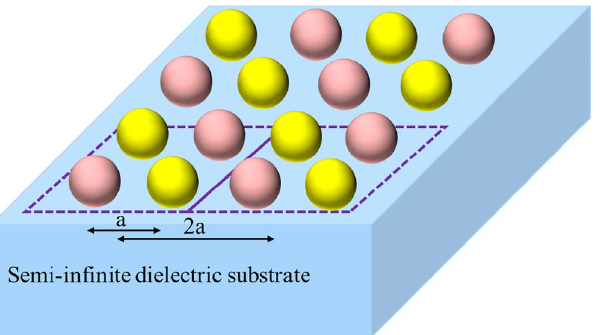
Figure 3. A substrated inhomogeneous metasurface consisting of combined silicon and gold nanoparticles with radii of 40